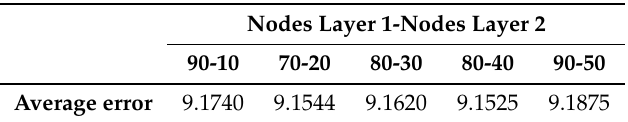
Table 5. Error distance in cm.